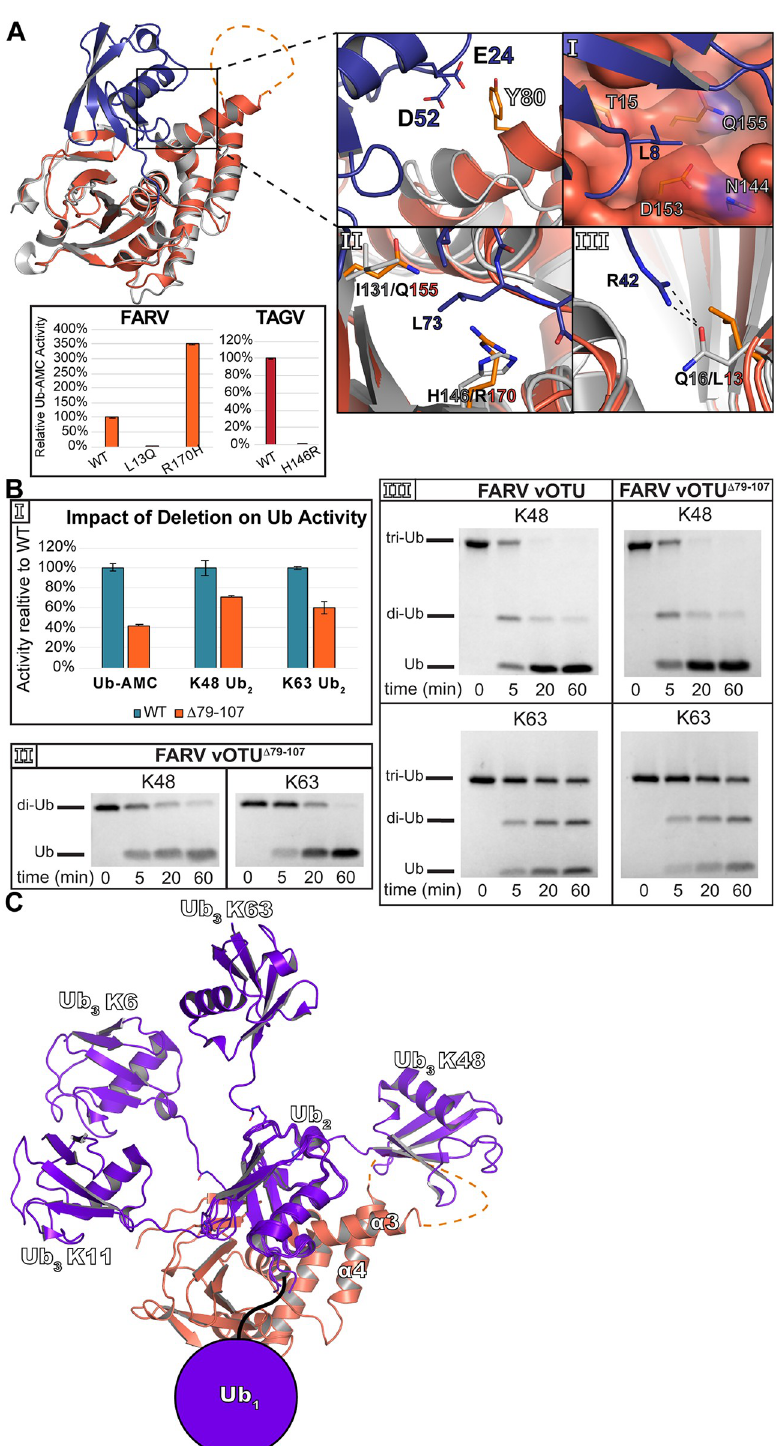
Fig 7. Model of molecular contributors to FARV mono- and poly-Ub activity. (A) FARV vOTU (reddish orange) in a Coot-calculated secondary structure overlay with CCHFV vOTU (gray) bound to Ub (PDB ID 3PRP). The selectivity pocket of FARV vOTU is shown in Panel I, with other elements potentially diminishing FARV vOTU Ub activity in Panels II and III. Black dashes show hydrogen bond interactions. Inset shows the Ub-AMC activity relative to WT of FARV and TAGV vOTU mutants. Error bars represent the standard deviation of two independent